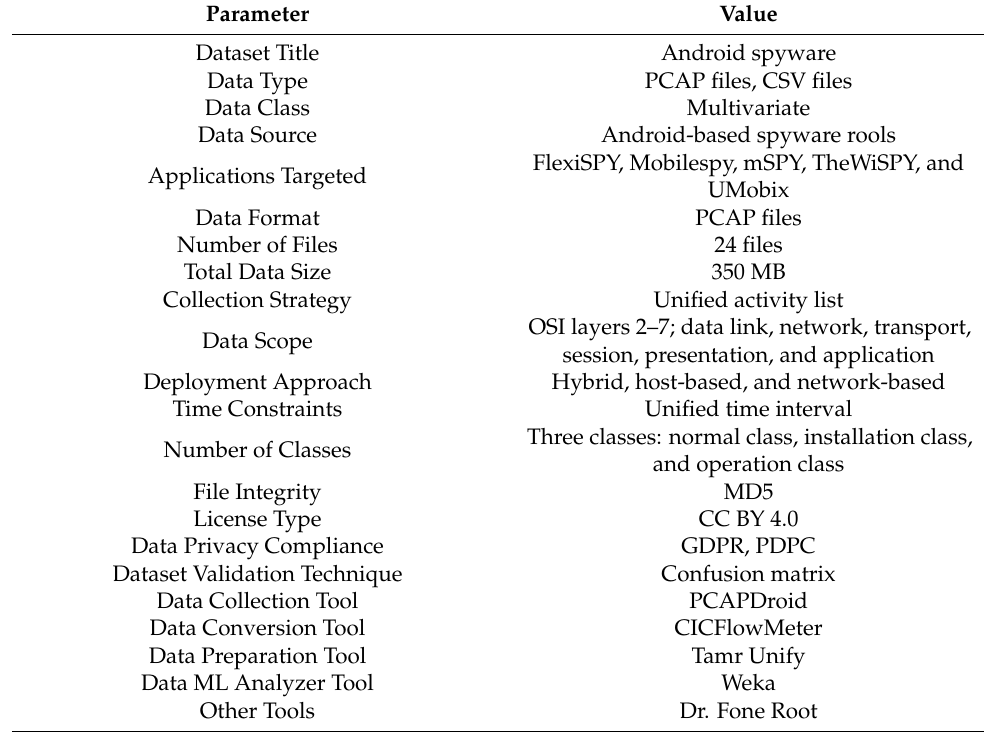
Table 2. Dataset identification details.